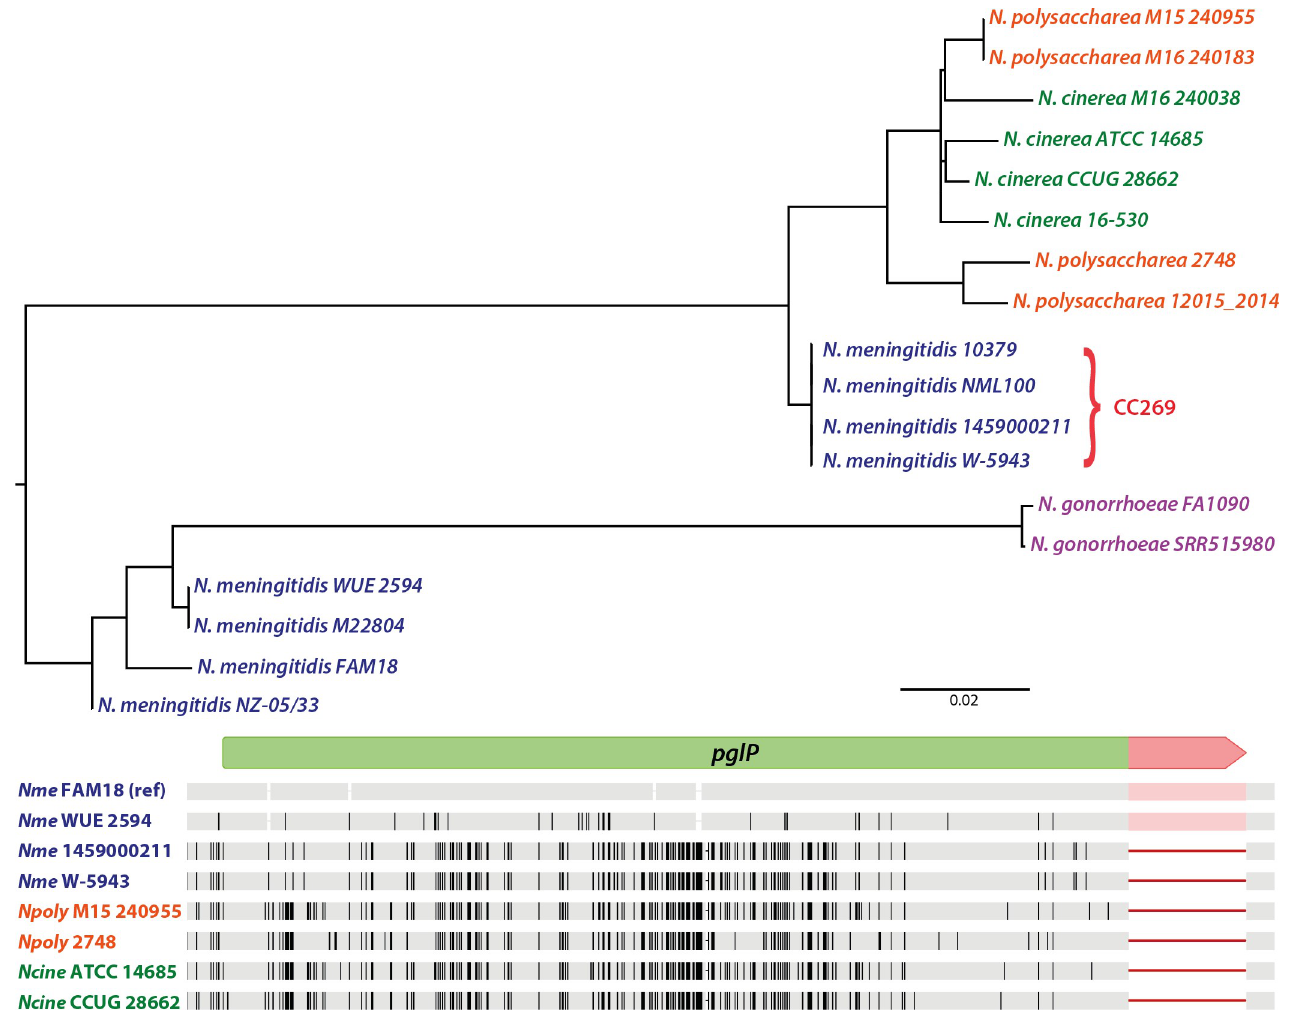
Fig 7. HGT-mediated acquisition of an intact pglP allele in CC269 strains. ORF nucleotide sequences from pglP alleles (excluding the ORF—extending CREE insertion) were aligned for phylogenetic sequence analyses using Clustal W (top panel). Multiple-alignment view of the variant nucleotide sites detected in pglP with that of FAM18 set as a reference sequence (bottom panel). The FAM18 allele contains the C -terminal, ORF—extending CREE insertion (segment in pink). Each SNP that differed from FAM18 is shown as a single line with thicker lines indicative of multiple neighboring SNPs. The sequence identities of another N . meningitidis pglP pseudogene, two CC269 alleles, two N . polysaccharea alleles and two N . cinerea alleles generated using ParSNP are shown. Note the absence of the CREE sequences in the CC269, N . polysaccharea and N . cinerea alleles and that greater than 80% of all pglP alleles in CC269 strains are 100% identical to those identified